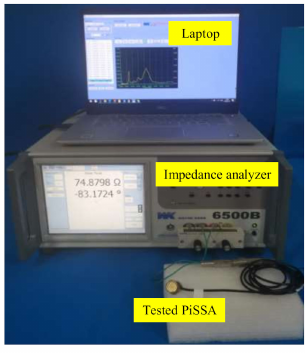
Figure 12. Experimental setup.